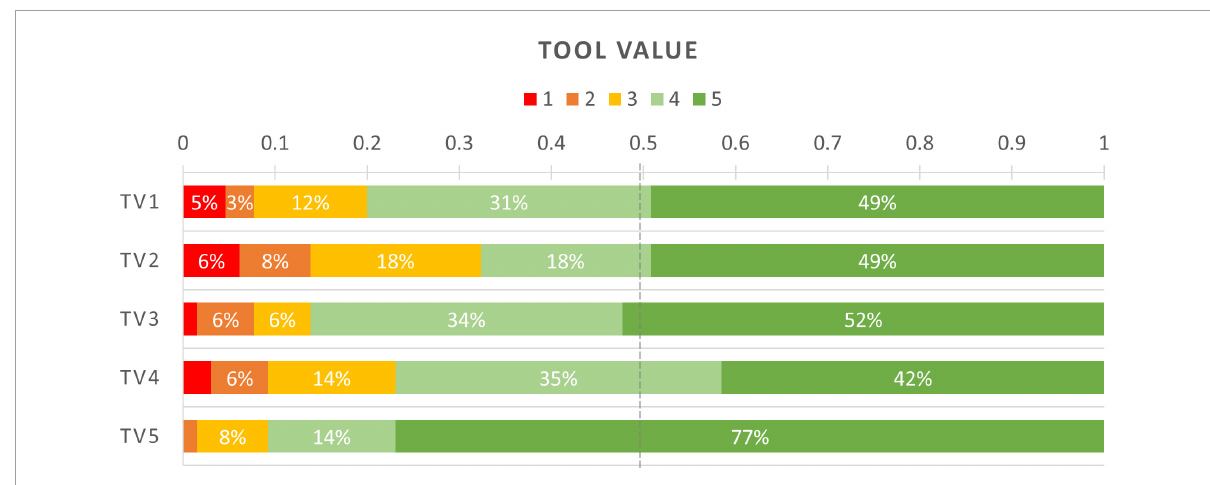
FIGURE3 Results of Likert-scale dimension of the value of virtual reality (VR) as a tool.